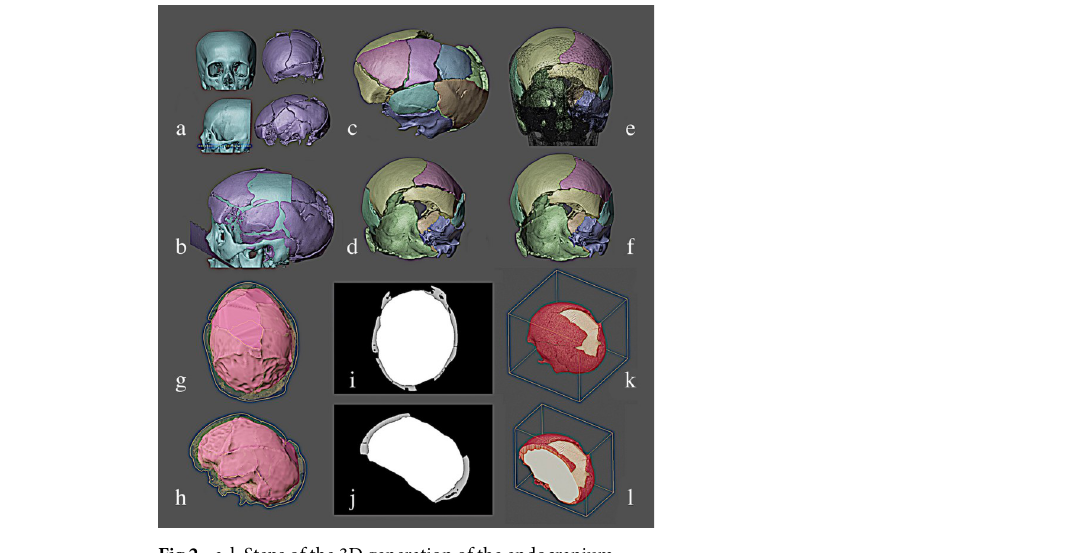
Fig 2. a-l. Steps of the 3D generation of the